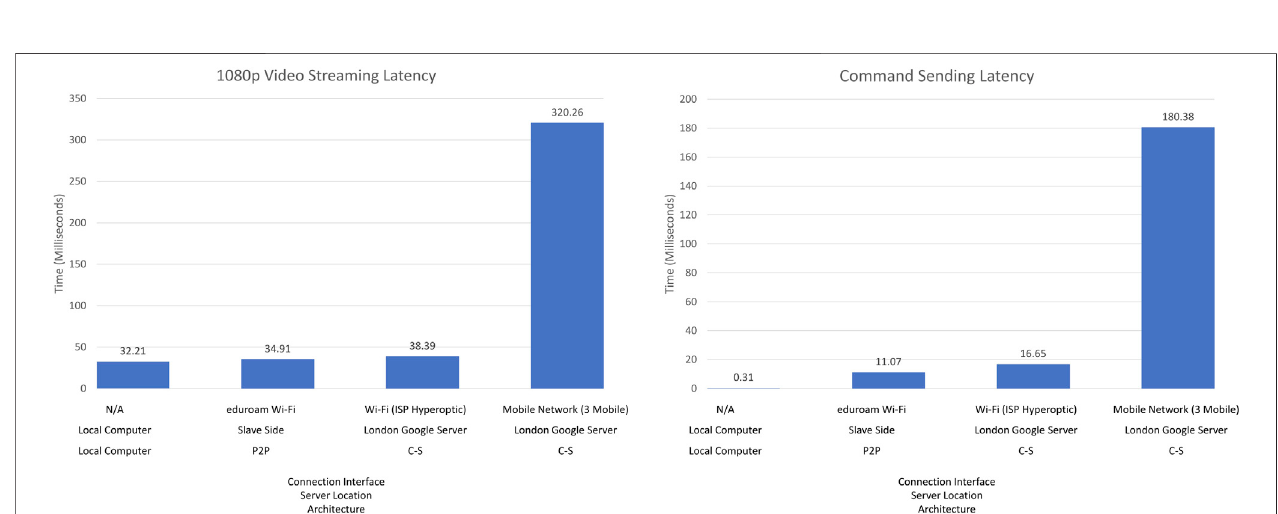
FIGURE 12 | Client-Server architecture with cloud servers for remote control of the robotic training setup.